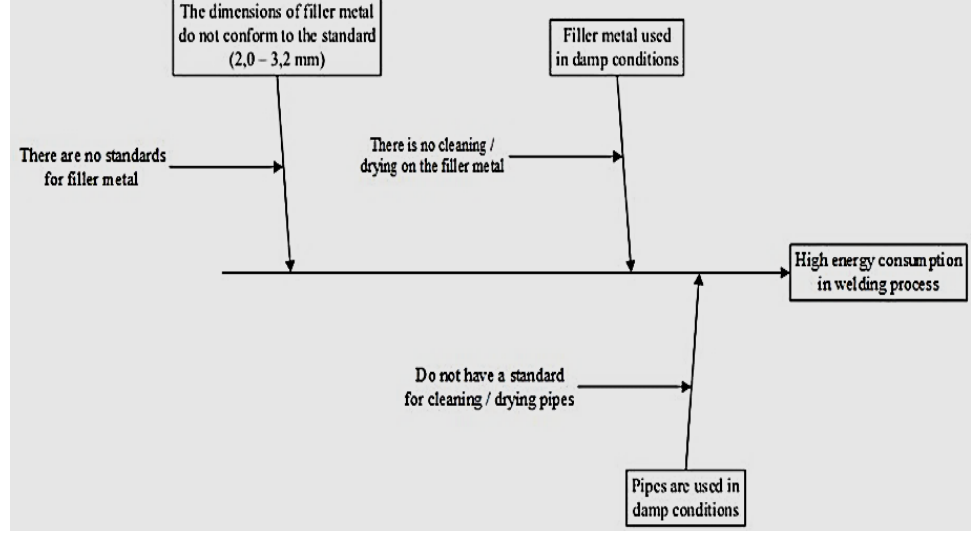
Fig. 4. Fishbone diagram of material